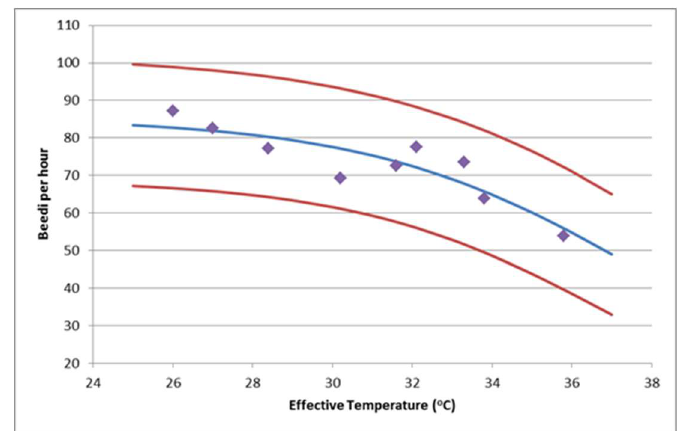
Figure 2. The group data from Nag and Nag (1992) [15]: beedi/h (dots); Fitted marginal distribution of absolute production, with a 90% interval on the individual output T 0 = 19.7 °C, mean ψ = 85.4, SDτ = 9.97, slope b = −0.285, scale θ = 13.6.